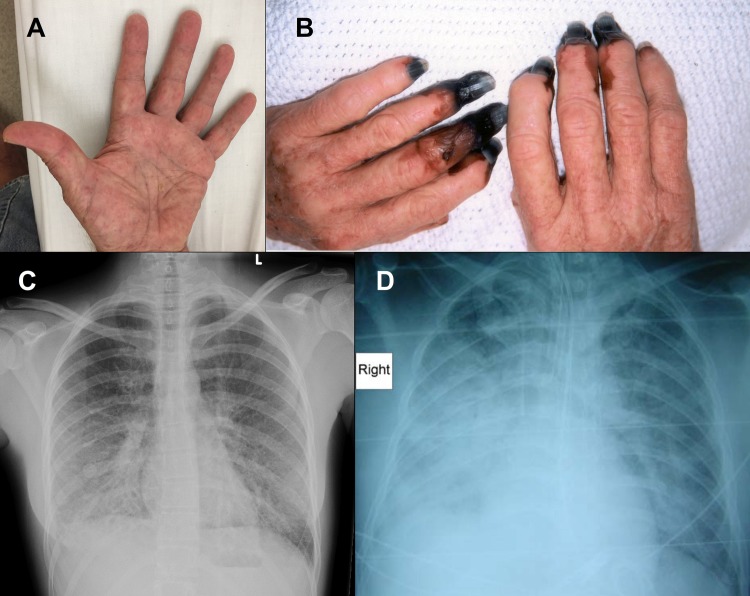
A–Macular petechial rash of the palms in a patient with SFG infection, B–Digital ischemia in a patient with SFG infection; this patient later required digital amputation, C–CXR demonstrating bilateral patchy non-confluent alveolar opacification in a patient with scrub typhus, D–CXR demonstrating right middle and lower lobe pneumonia and early left lower lobe consolidation in a patient with severe SFG infection in ICU. (Panels B and D have been published previously (10)).